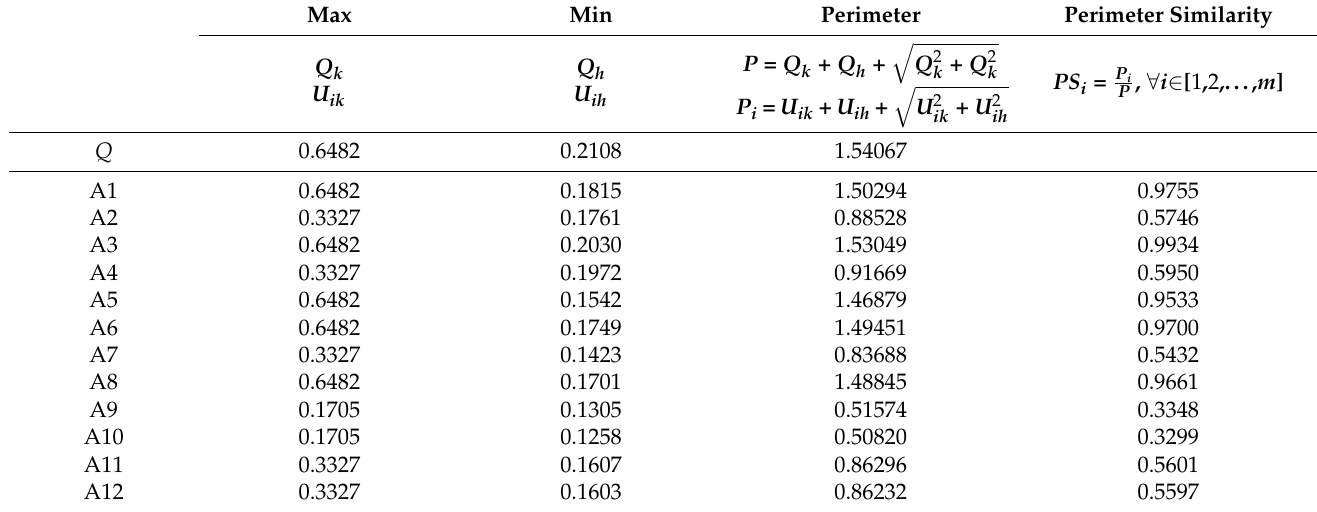
Table 19. Perimeter similarity of each alternative.